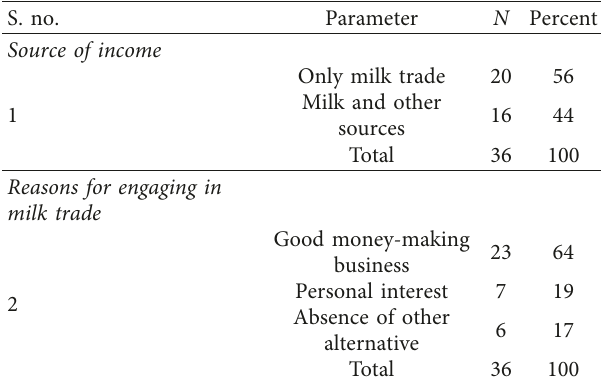
Table 1: Income source and reasons for engaging in the business. S.